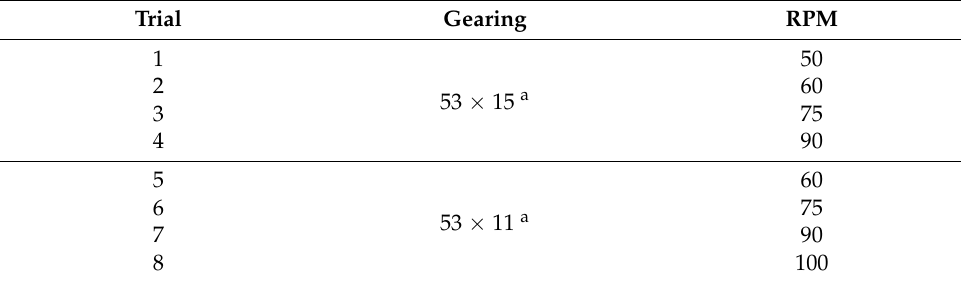
Table 1. Gearing and RPM during each